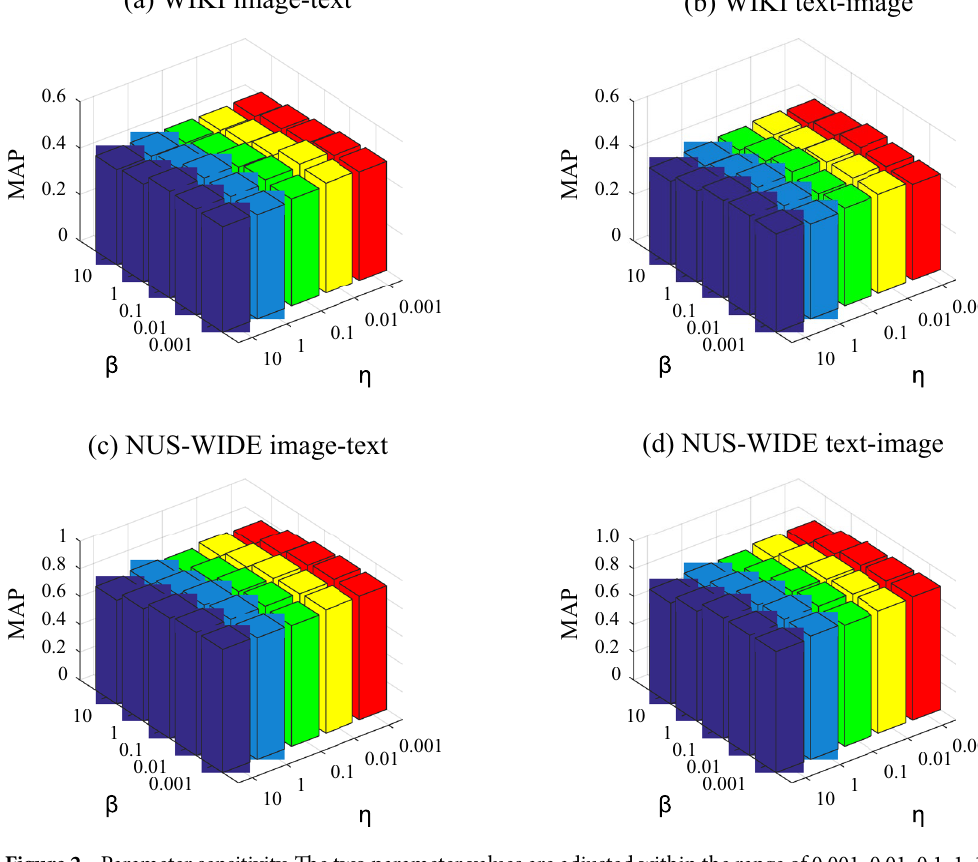
Figure 2. Parameter sensitivity. The two parameter values are adjusted within the range of 0.001, 0.01, 0.1, 1, 10. The parameters’ query performance is relatively sensitive.